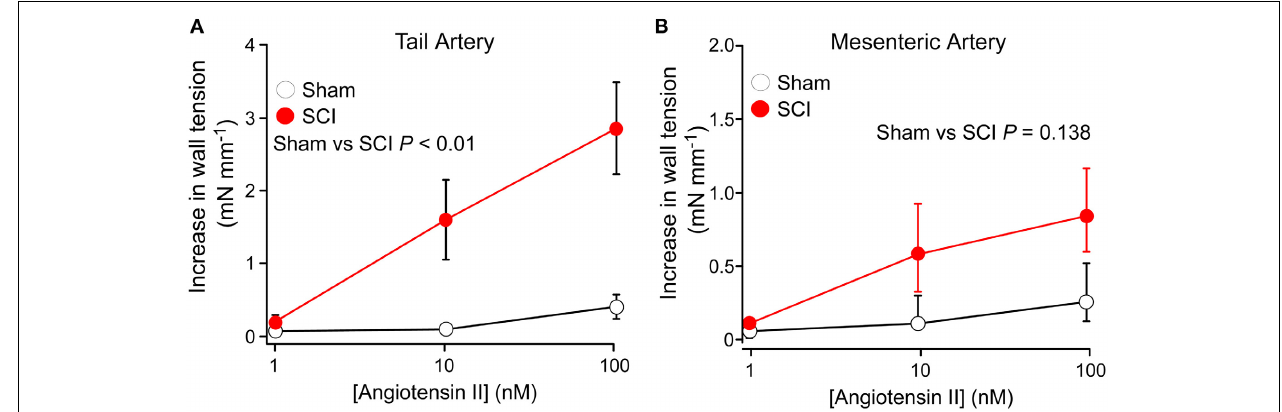
FIGURE 2 | Spinal cord injury (SCI) increased the responsiveness of tail arteries to angiotensin II (Ang II). (A,B) Concentration–contraction curves for Ang II (1–100nM) in tail arteries (A) and mesenteric arteries (B) from sham-operated ( open circles ; tail artery n = 8, mesenteric artery n = 7) and SCI rats ( solid red circles ; tail artery n = 8, mesenteric artery n = 6). In (A), the data are presented as mean and